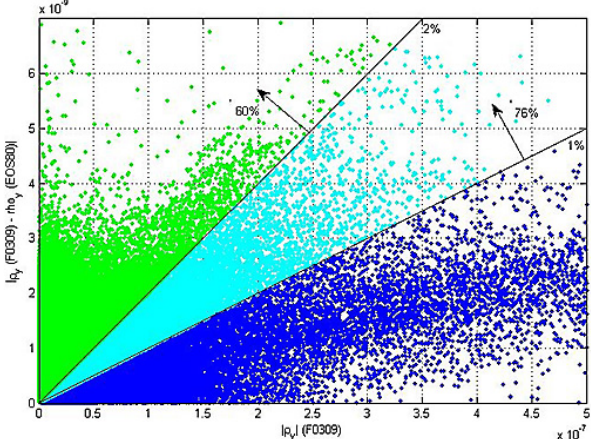
Fig. 2. The northward density gradient at constant pressure (the horizontal axis) for all the data in the ocean atlas of Gouretski and Koltermann (2004) for p> 1000dbar. The vertical axis is the magni- tude of the difference between evaluating the density gradient using S dens as the salinity argument in the TEOS-10 expression for den- A sity compared with using S P in the EOS-80 algorithm for density. The latter corresponds to current practice and for the purpose of this figure is not significantly different from using S R in